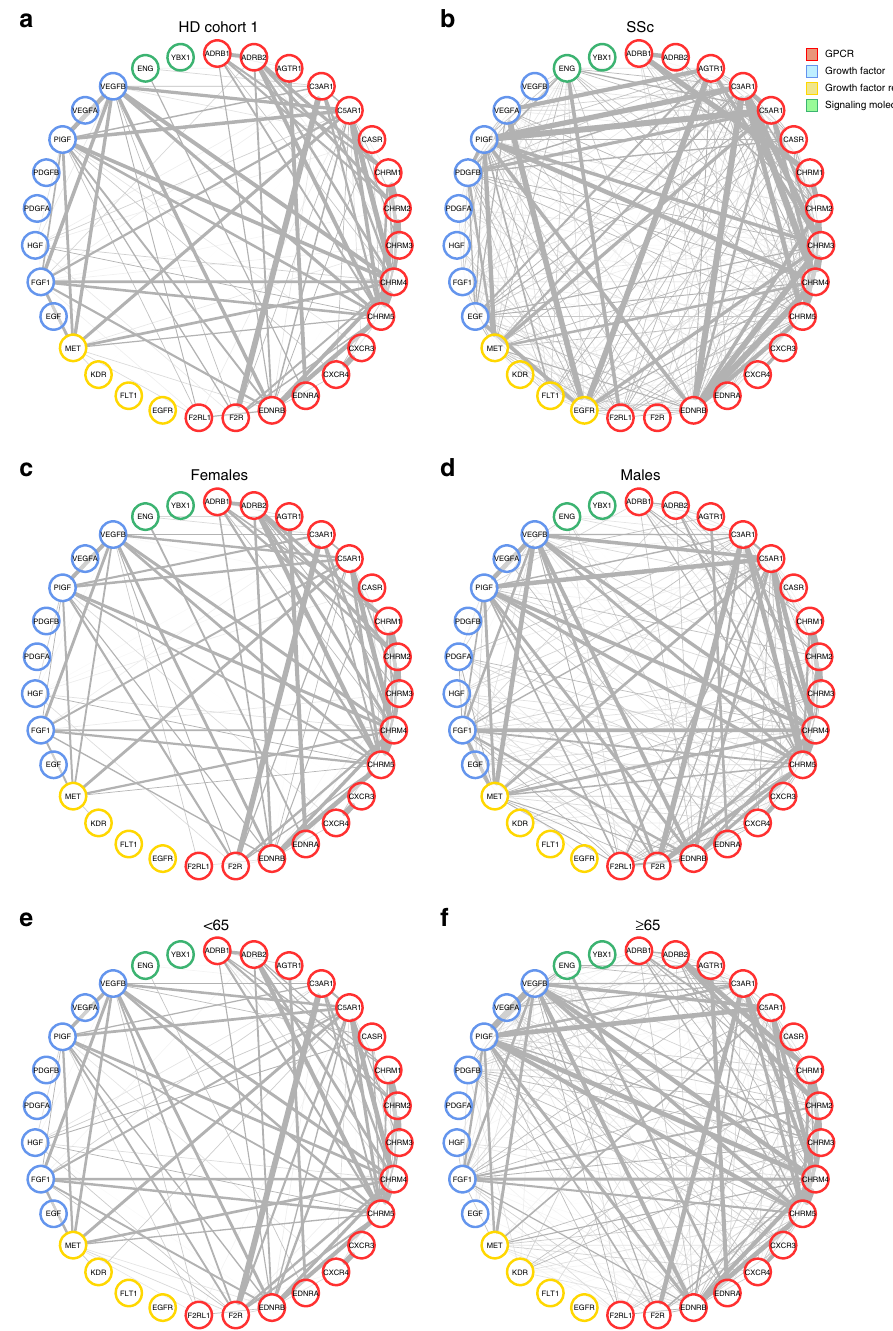
Fig. 2 Effects of gender, age, and systemic sclerosis on autoantibody correlations. We analyzed the relationships among the different autoantibodies (aab) in sera from healthy donors (HD) and the effects of gender and age, as shown by circular networks based on Spearman ’ s rank correlation coef fi cients for aab. Circle plots show the correlation matrix of aab comparing each condition: a all HD evaluated, b patients with systemic sclerosis (SSc; Supplementary Table 1, cohort 1; Supplementary Table 2, aab dataset 1); subgroups of HD (cohort 1) analyzed according to c , d gender and e , f age (< and ≥ 65